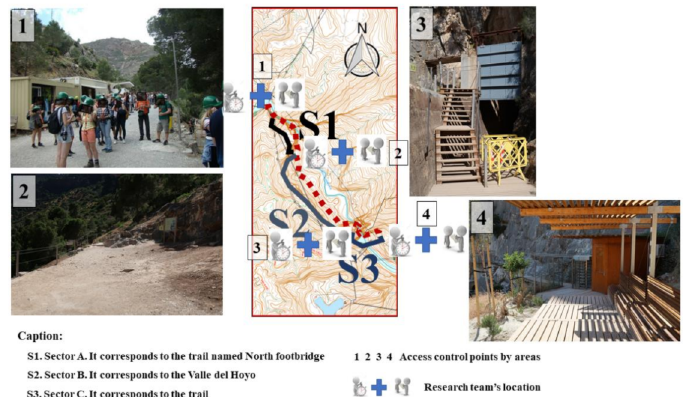
Figure 2. Research teams’ locations in the access points for the circulation of the hikers by